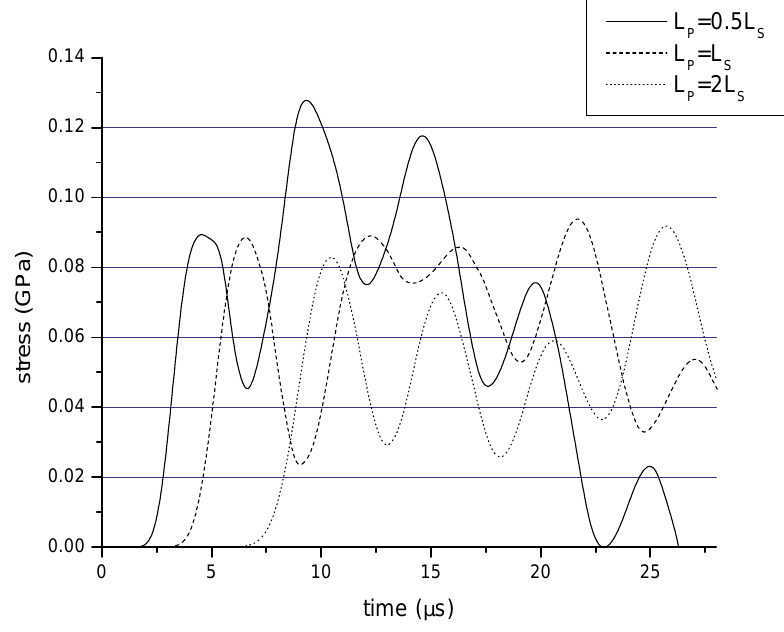
Fig. 6. Stress response in copper impactor with varied length of PMMA pad (Case 3).